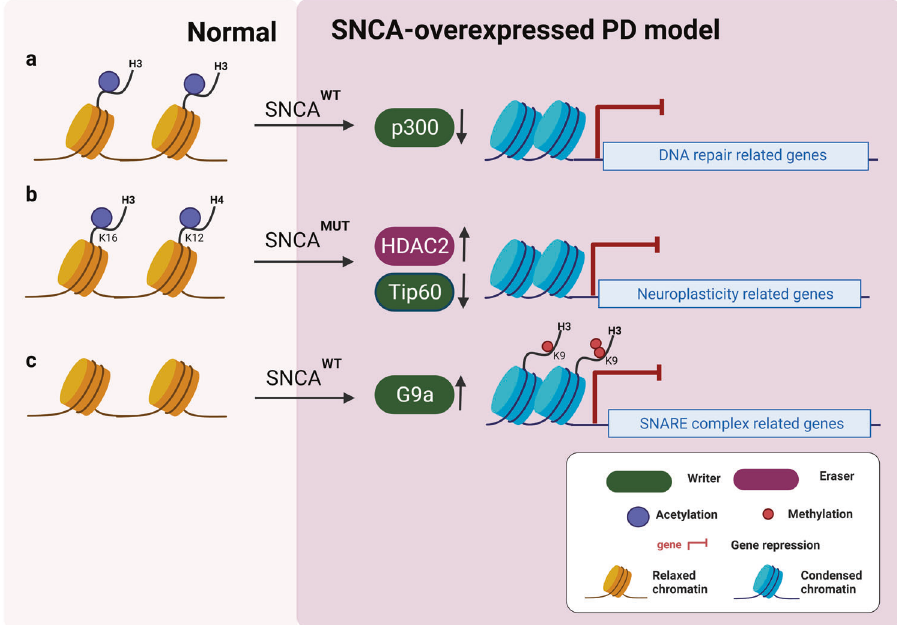
Fig. 7 Effect of α -synuclein overexpression on PD-related gene expression. a Overexpression of wild-type α -synuclein (SNCA WT ) reduces H3 acetylation levels by suppressing p300 expression, resulting in downregulating key genes related to DNA repair. b Mutant α -synuclein (SNCA MUT ) expression induces HDAC2 expression but inhibits Tip60 expression, leading to the decrease of H3K16ac and H4K12ac at the neuroplasticity related genes. c Wild-type α -synuclein overexpression increases G9a expression, which negatively regulated SNARE complex gene expression (i.e., LICAM and SNAP25) by depositing